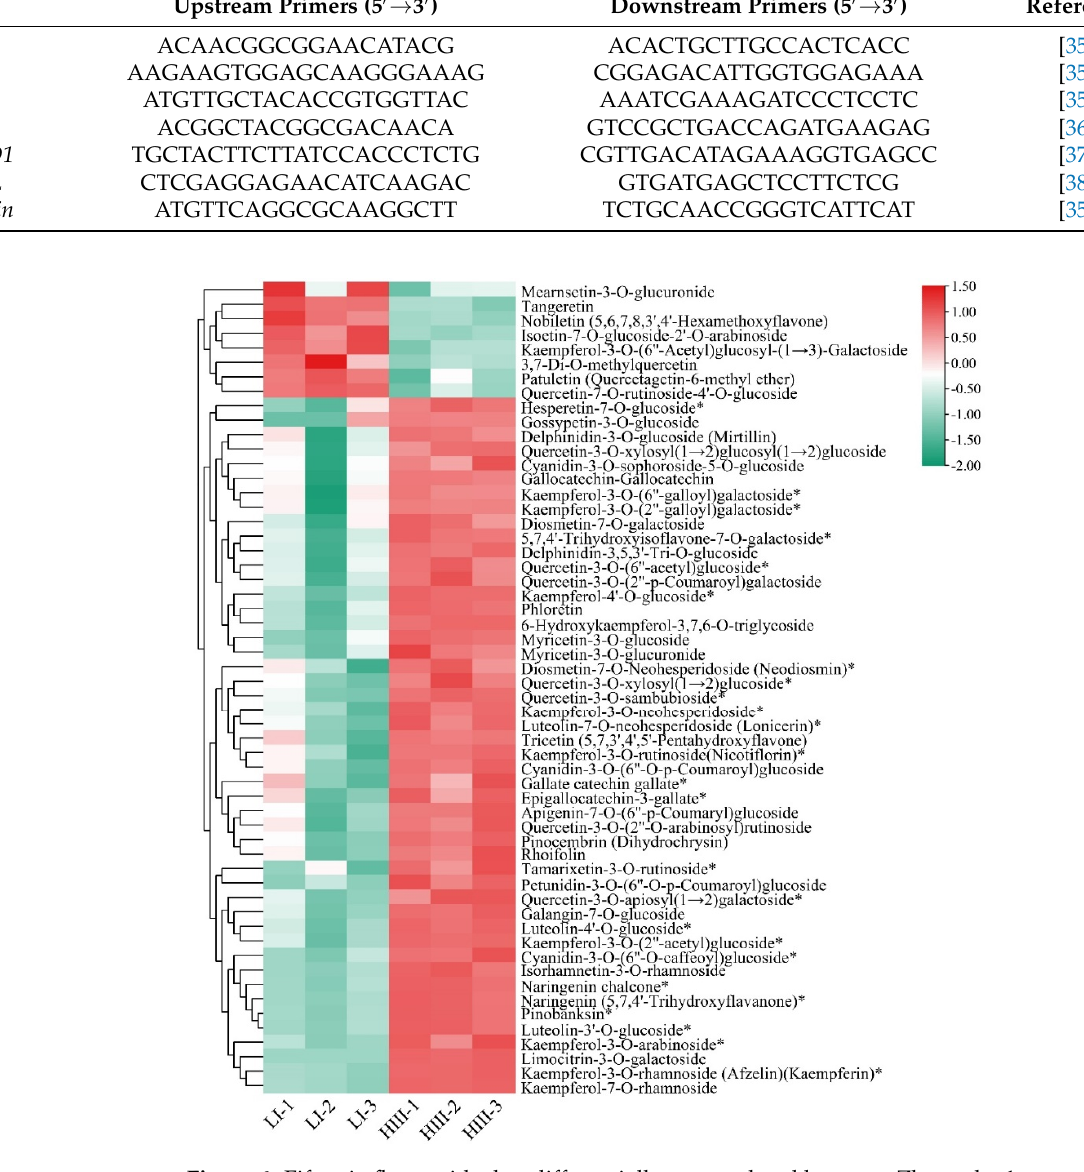
Figure 6. Fifty-six flavonoids that differentially accumulated between Zhongzhe 1 sugarcane and G160 sugarcane. * indicates the existence of isomers of the compound.